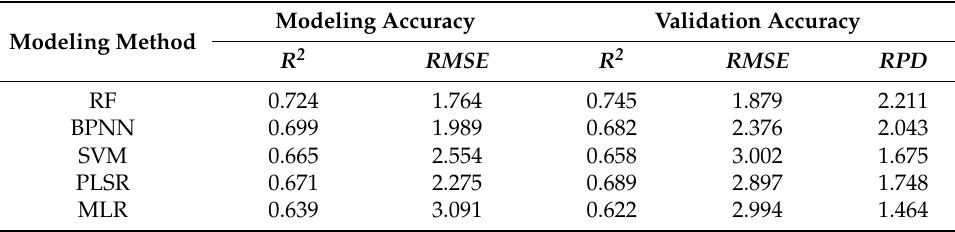
Table 10. Accuracy statistical results of soil salinity index retrieval model based on SSRI.